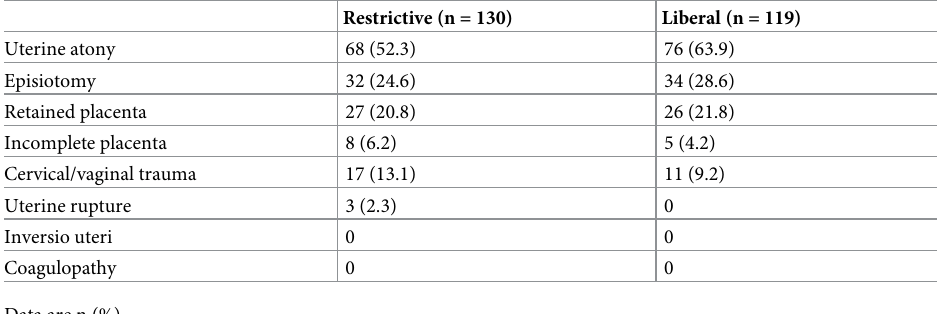
Table 3. Causes identified for